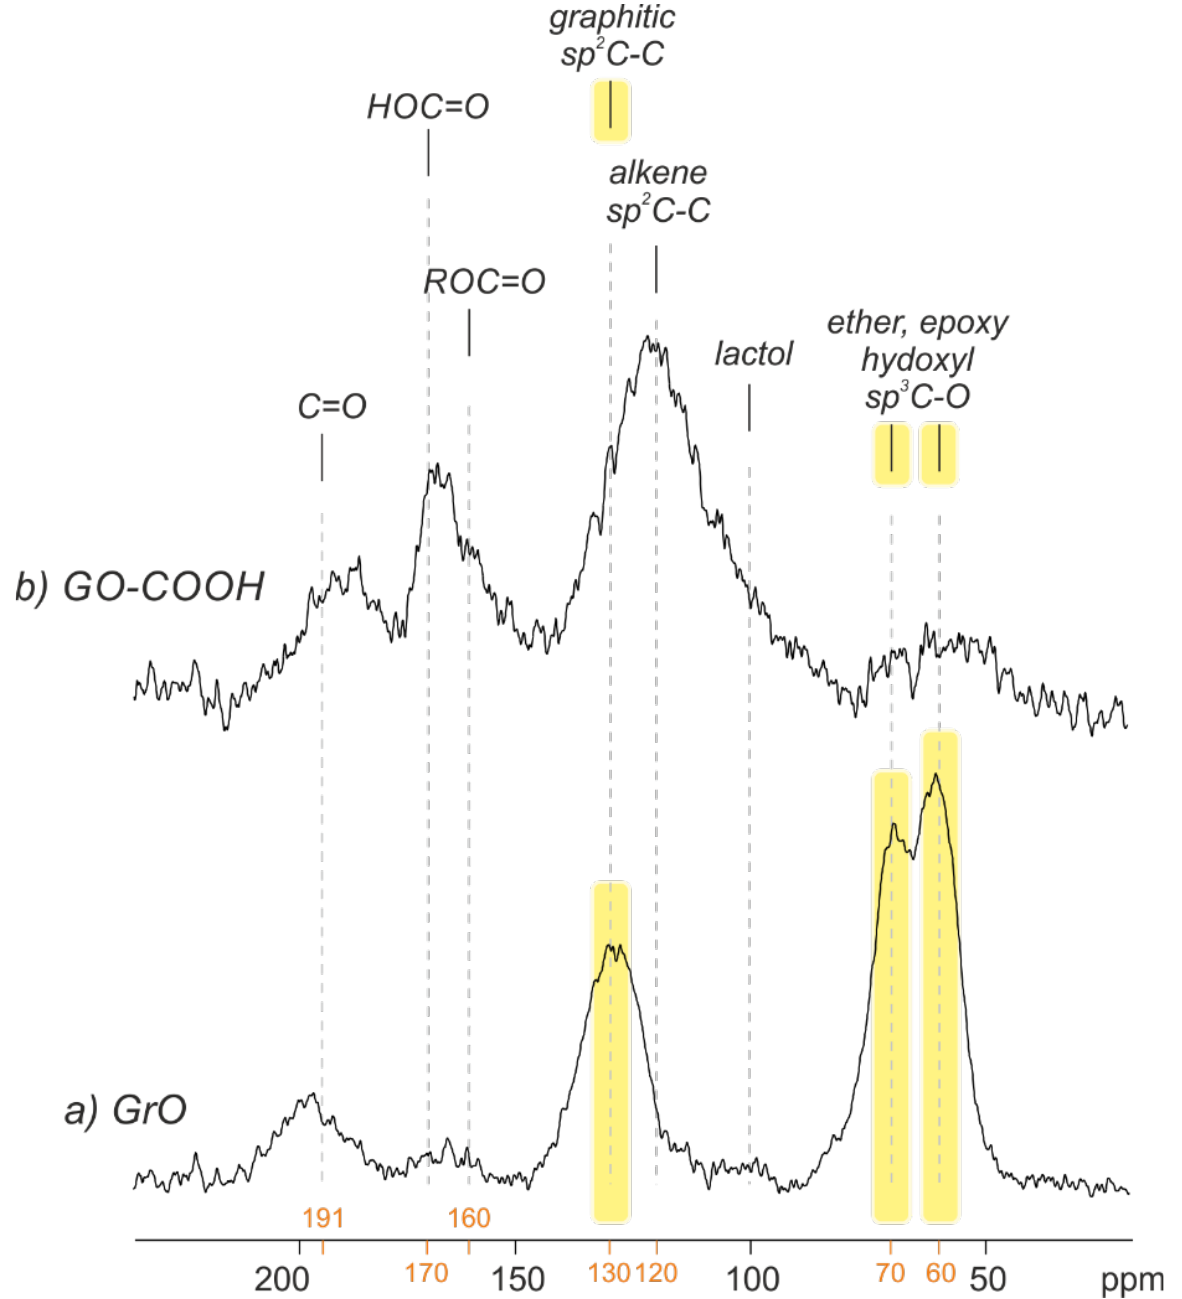
Figure 4. Direct-pulse 13 C MAS NMR spectra of GrO and GO-COOH samples. The TG-MS results of powdered GrO, rGO and GO-COOH samples shown in Figure 5A–C, respectively revealing the difference in terms of how KMnO 4 reacts with a single-layer rGO relative to a graphitic stacked material. Table 3 shows the integrated areas in terms of gravimetric weight loss for MS signals for water, CO and CO 2 .